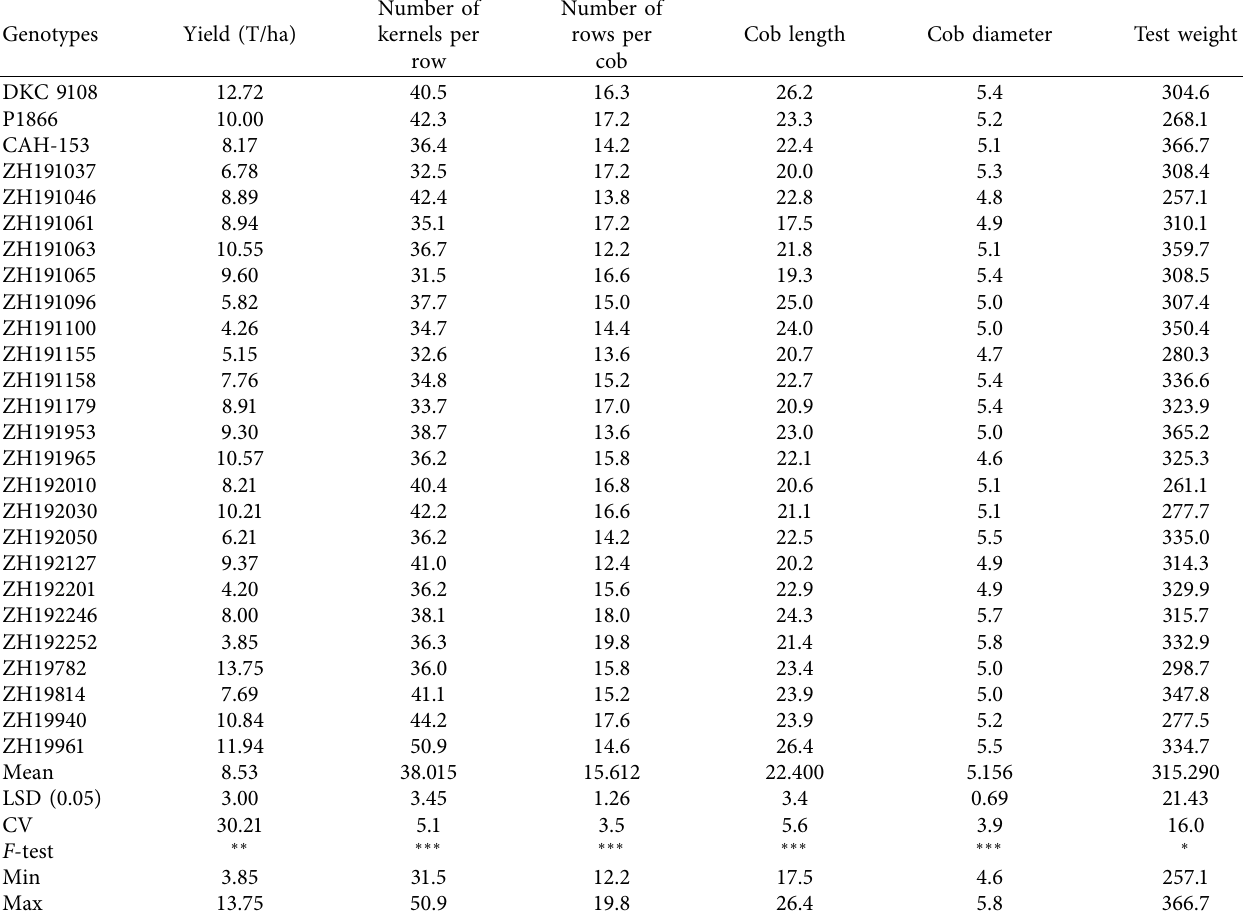
Table 5: Mean performance and analysis of variance of yield and cob